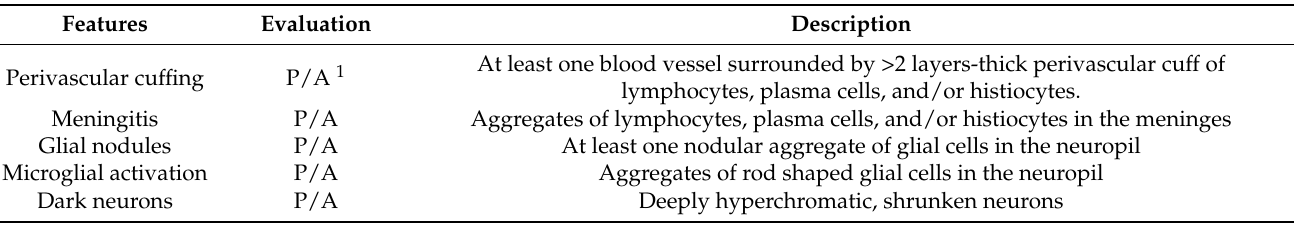
Table A3. Histopathological features evaluated in the central nervous system (brain: frontal cortex-caudate nucleus, parietal